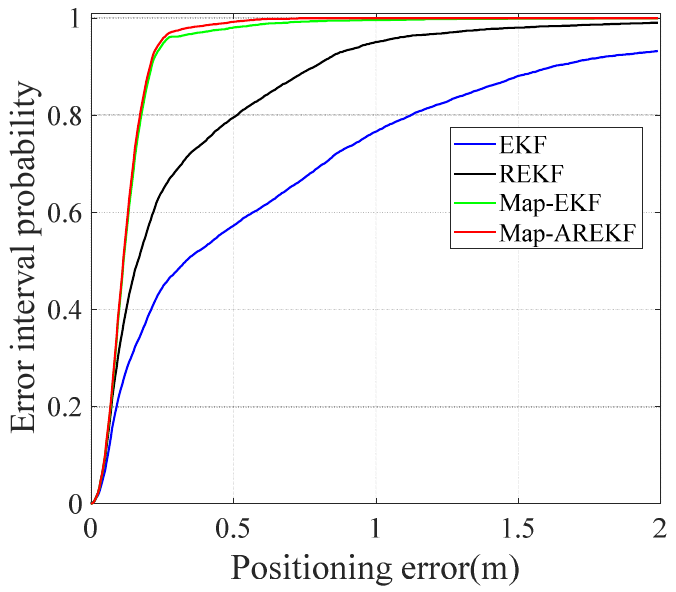
Figure 29. Probability statistics of algorithm localization error for Experiment 4.